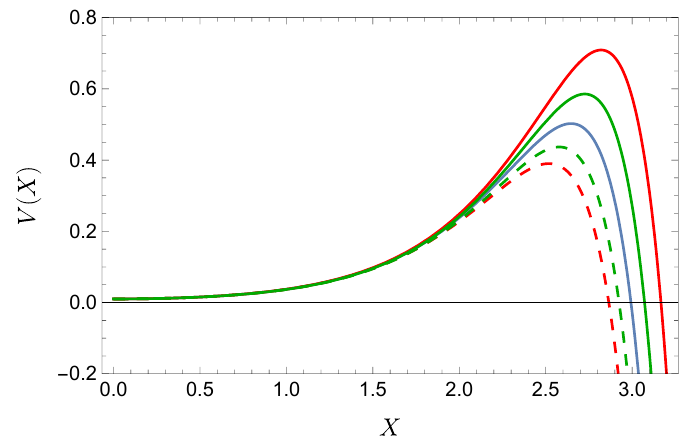
Figure 3 . Potential for X , in the presence of a scalar, with ND boundary conditions. Left: the parameters are ‘ uv = 10 , ‘ ir = 9 . 9 , (cid:15) = 10 − 2 , ( v uv , α ir ) = (0.03, 0.001) (red), ( − 0.03, 0.001) (red dashed), (0.0003, 0.05) (green), (0.0003, − 0.5) (green dashed), with 12 M 3 the potential without the scalar contribution (blue), with the unstable extremum. The effect of the scalar dynamics is to change X ∗ , but the unstable dS extremum stays